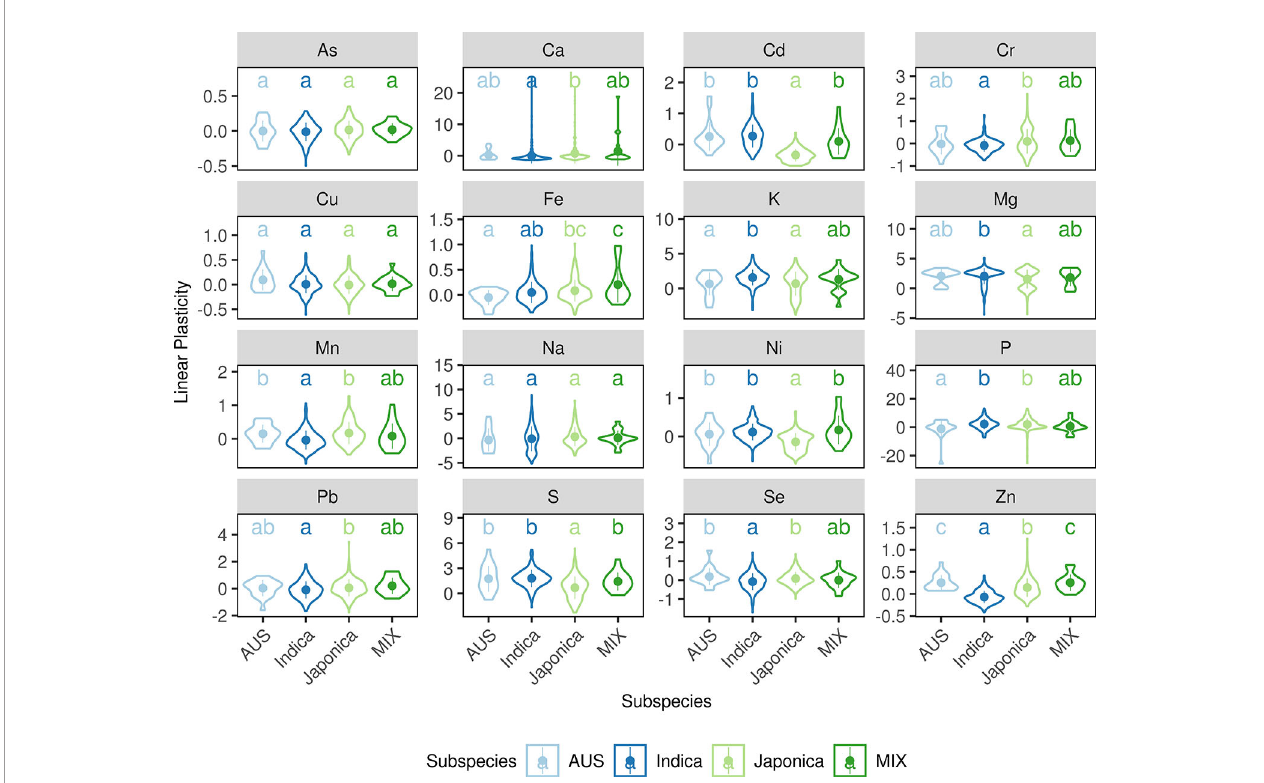
FIGURE 4 | Violin plots of linear plasticity in each rice subspecies. The width of each violin denotes the kernel density, the point and line in each violin denotes the mean value and the standard deviation. The x-axes show the rice subgroups, and the y-axes show the values for linear plasticity. The letters above each violin denote the signi fi cant differences between different subspecies (Kruskal-Wallis test, P < 0.05).